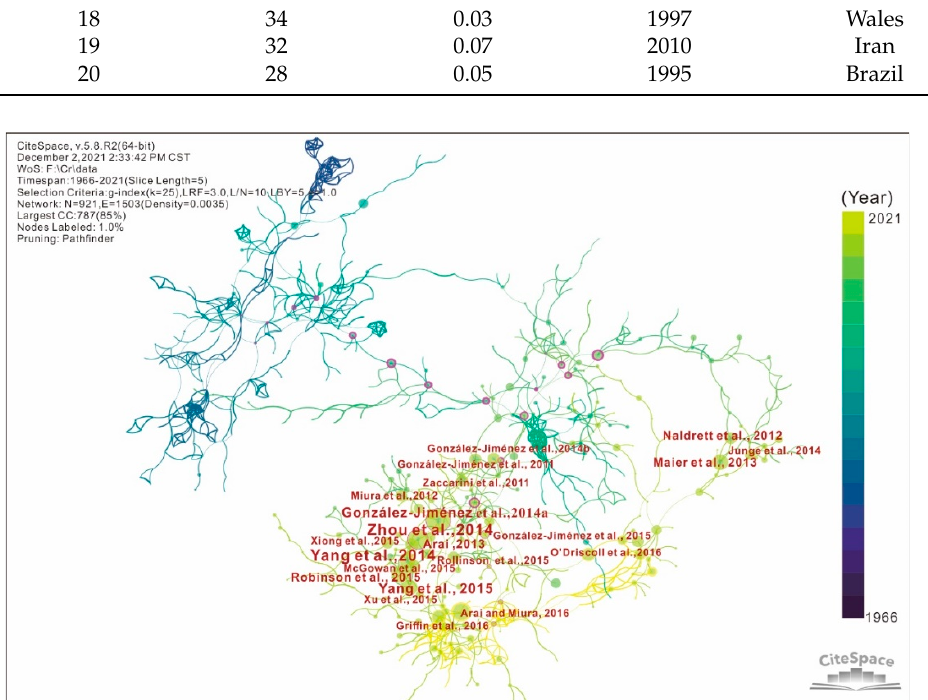
compared the characteristics of discordant and concordant chromitite pods in the Wadi